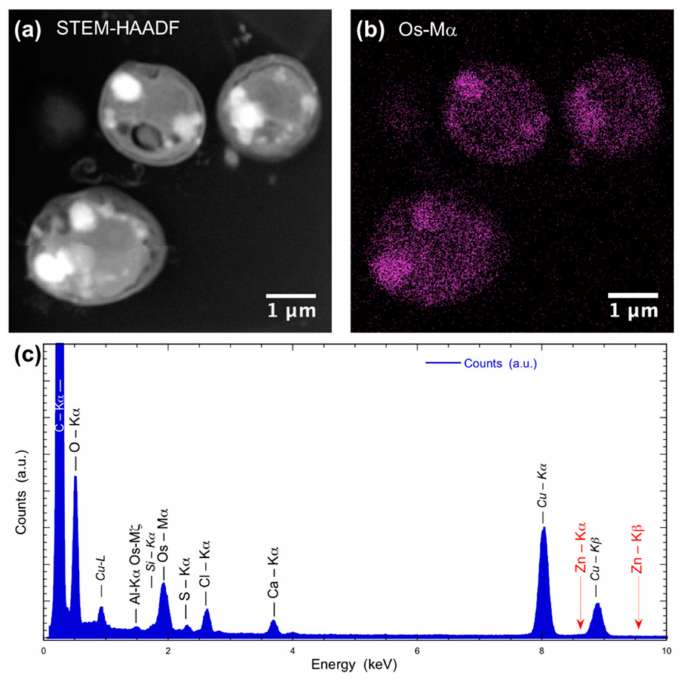
Figure 8. ( a ) STEM-HAADF and ( b ) STEM-XEDS images of Chlorella vulgaris ultrastructure after contact with ZnO nanoparticles (10 –3 M) in Seine river. Bright areas within the cell are due to the accumulation of contrasting agent OsO 4 . ( c ) XEDS spectrum showing the absence of Zinc.